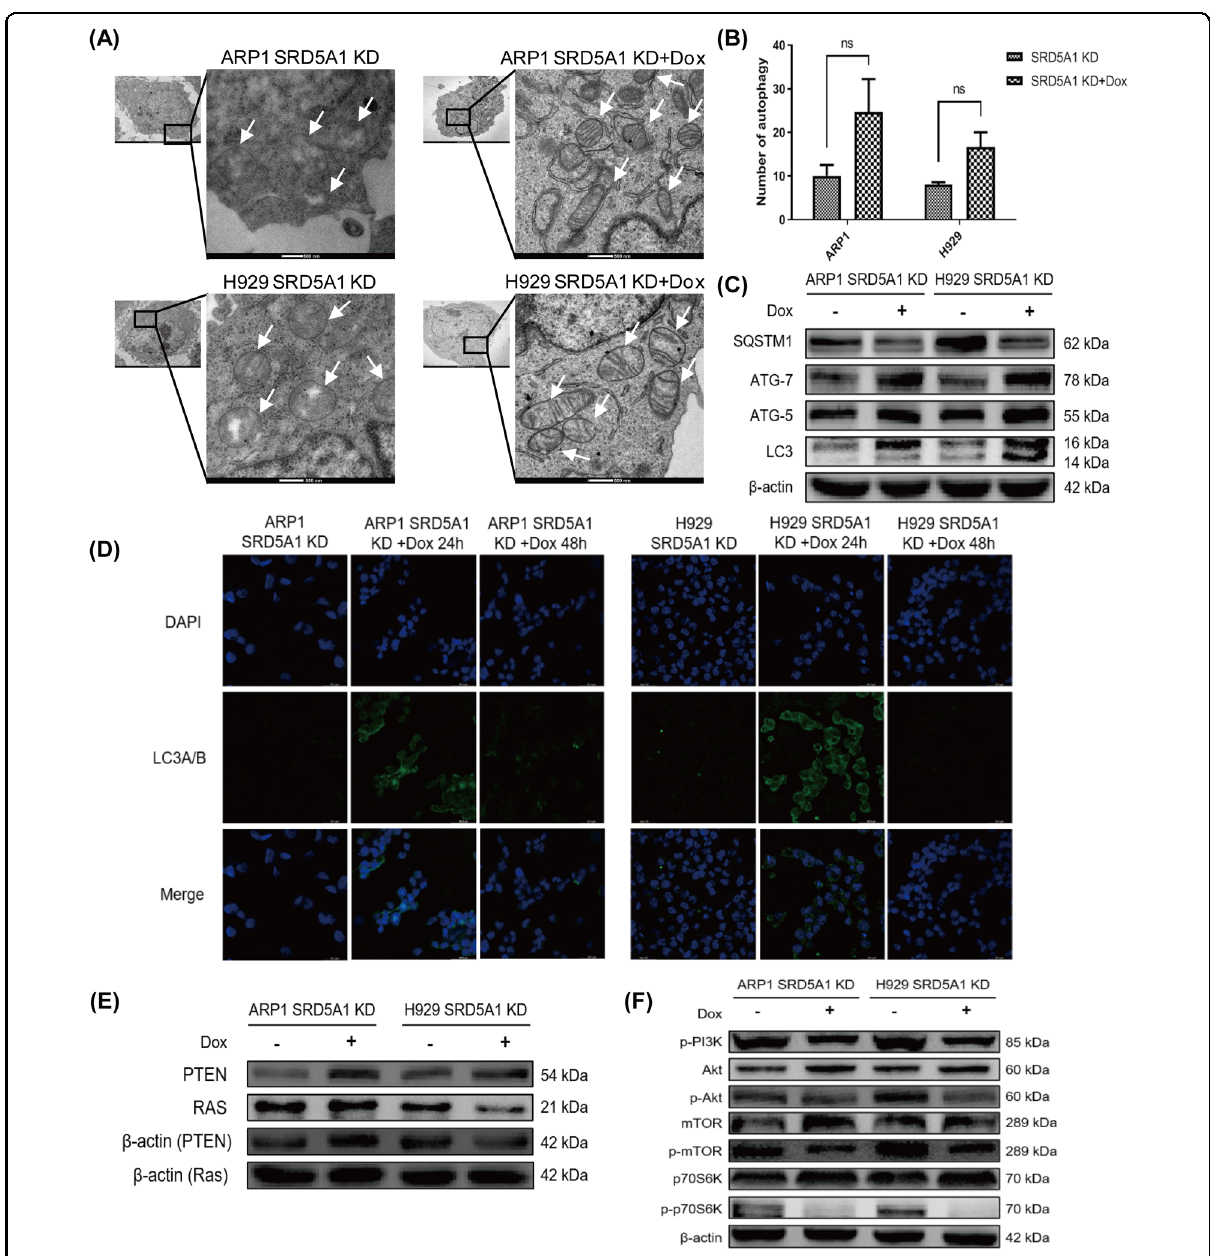
quanti fi ed. One-way analysis of variance (ANOVA) was carried out. C Western blotting assay on SQSTM1, ATG-7, ATG-5, and LC3 expression in ARP1- and H929-SRD5A1-KD cells treated with or without Dox. D Immuno fl uorescence staining of LC3 expression in ARP1- and H929-SRD5A1-KD cells treated with or without Dox. E Western blotting assay on PTEN and Ras expression in ARP1- and H929-SRD5A1-KD cells treated with or without Dox. F Expression of a marker protein in PI3K/Akt/mTOR signaling was detected by western blotting in ARP1 and H929